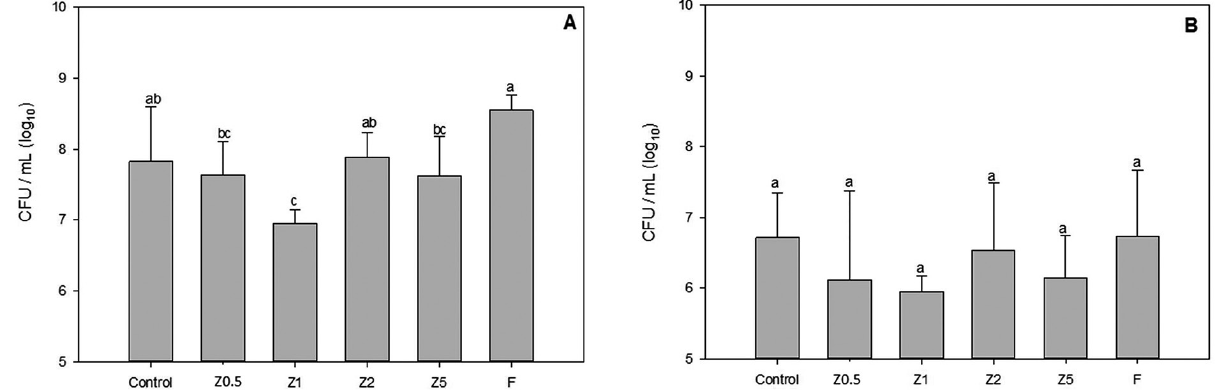
Figure 3- Survival of E. faecalis ATCC4083 after direct contact with temporary filing materials (A) for 1 h and (B) for 24 h